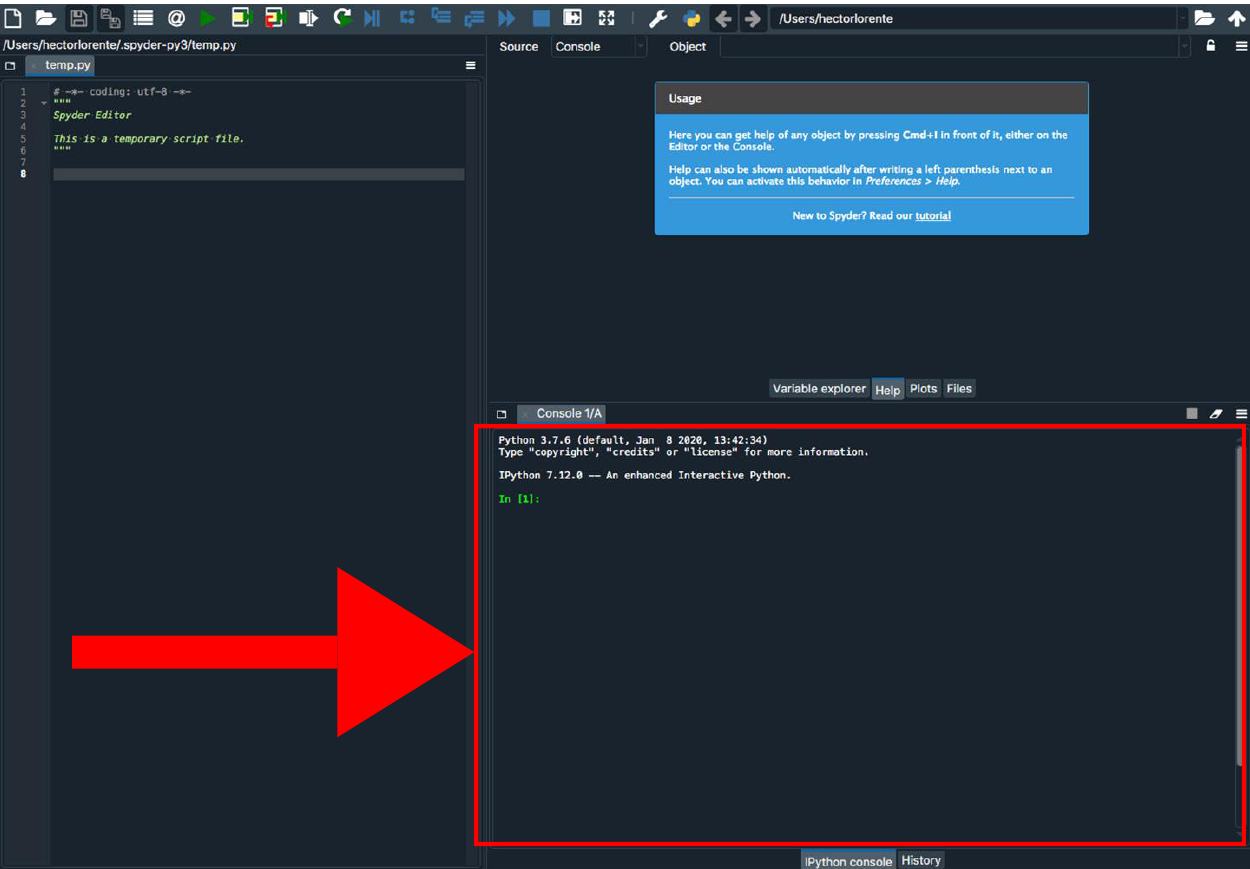
Figure 3. Spyder program interface. The red arrow indicates the Python console.